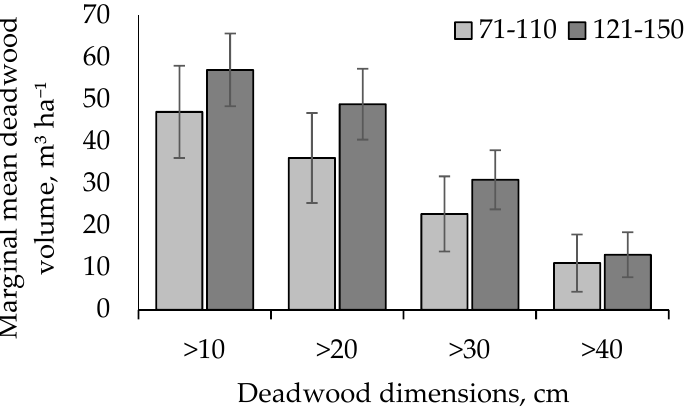
Figure 3. Volume of deadwood ( ± confidence interval) in recently unmanaged mature (71–110) and old-growth (121–150) stands by groups of deadwood dimensions.